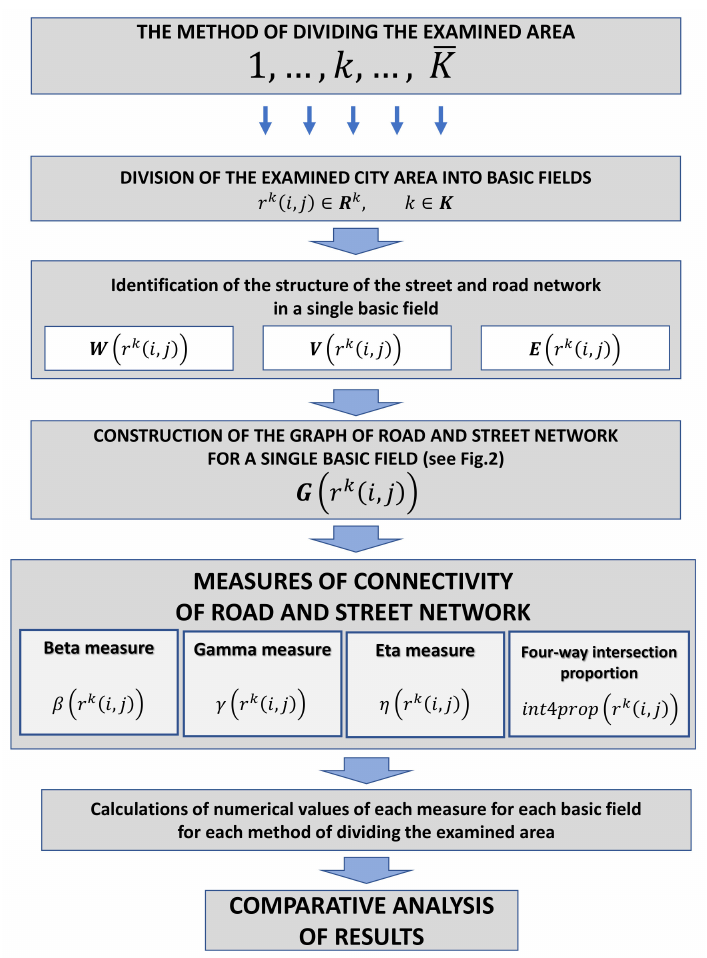
Figure 3. Scheme for the method of assessing the connectivity of the road and street network with selected